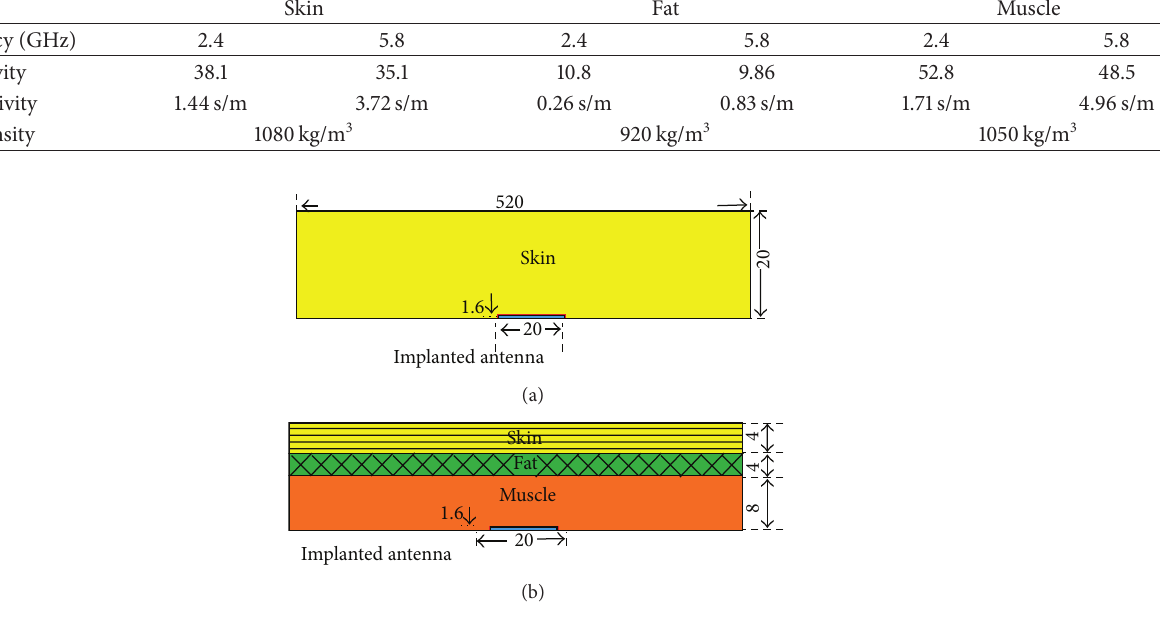
Figure 5: The designed antenna implanted in (a) skin tissue and (b) muscle-fat-skin tissues (measured in